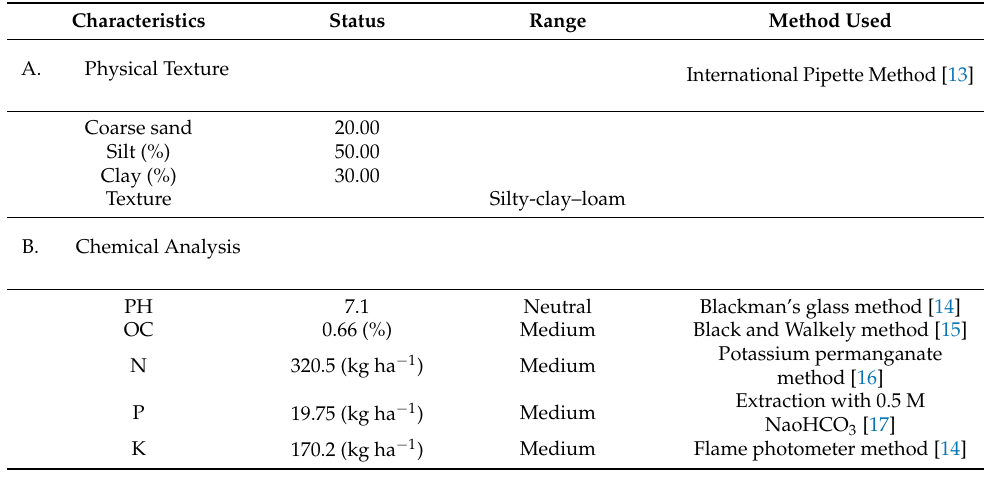
Table 1. Physico-chemical parameters of the soil of experimental